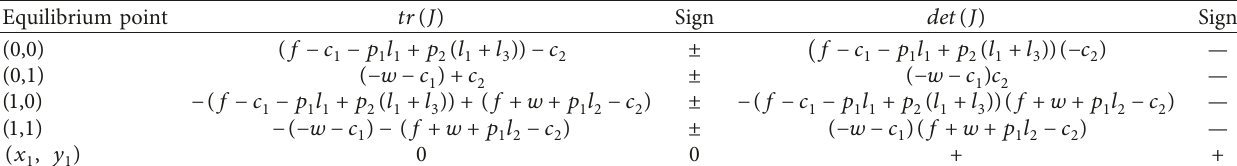
Table 3: Results of stability analysis of system